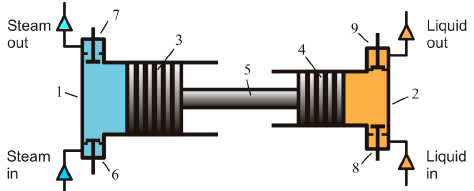
Figure 1. Scheme of a single-acting Worthington steam pump. 1 —steam cylinder, 2 —pumping cylinder, 3 —steam piston, 4 —pumping piston, 5 —connecting rod, 6 —steam inlet valve, 7 —steam outlet valve, 8 —liquid inlet valve, 9 —liquid outlet valve.